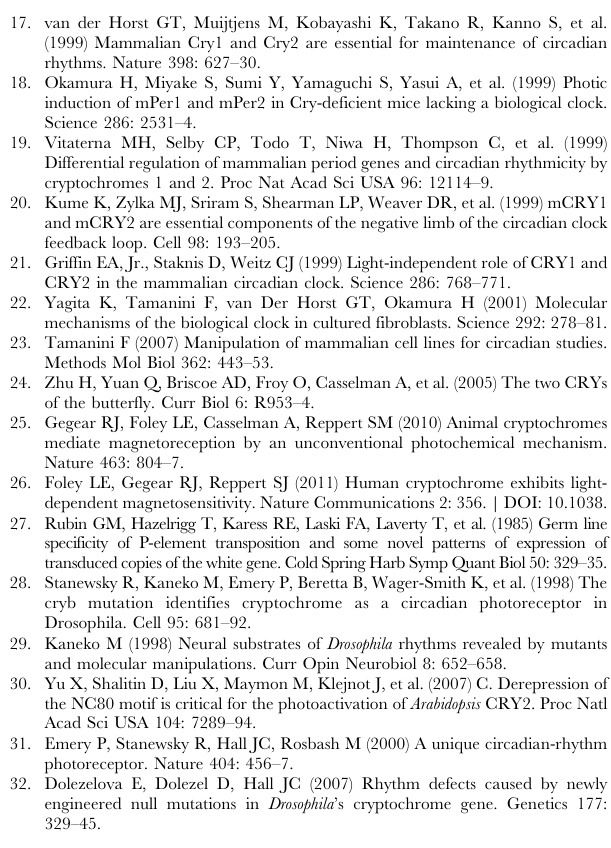
Figure S1 A - The UV-vis absorbance spectrum of purified HsCRY1 is shown in the solid line. The dashed line, which shows the absorbance spectrum of supernatant after thermally denatur- ing HsCRY1 by heating to 95 u C for 10 mins and centrifugation, was used to calculate the extinction coefficient. B - Fluorescence emission spectrum of purified HsCRY1 upon excitation at 365 nm. The broad peak between 440–460 nm is consistent with the presence of folate cofactor. C - Fluorescence excitation spectra of HsCRY1 monitored at an emission wavelength of 525 nm. The shoulder at 450 nm is consistent with the presence of a small quantity of oxidized flavin.